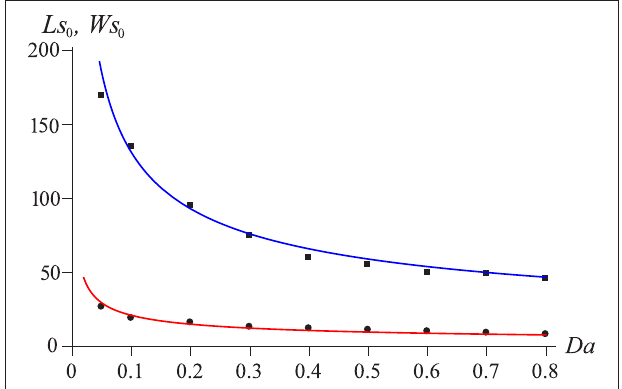
FIGURE 15 | The width ( W ) and length ( L ) of the widenings, as marked in Figure 13, as a function of the Damkölher number. The points represent the simulation data, whereas the curves are fit to 1 / √ Da dependencies: L ( Da ) 41.5 / √ Da (blue curve) and W ( Da ) 6.5 / √ Da (red curve). = =